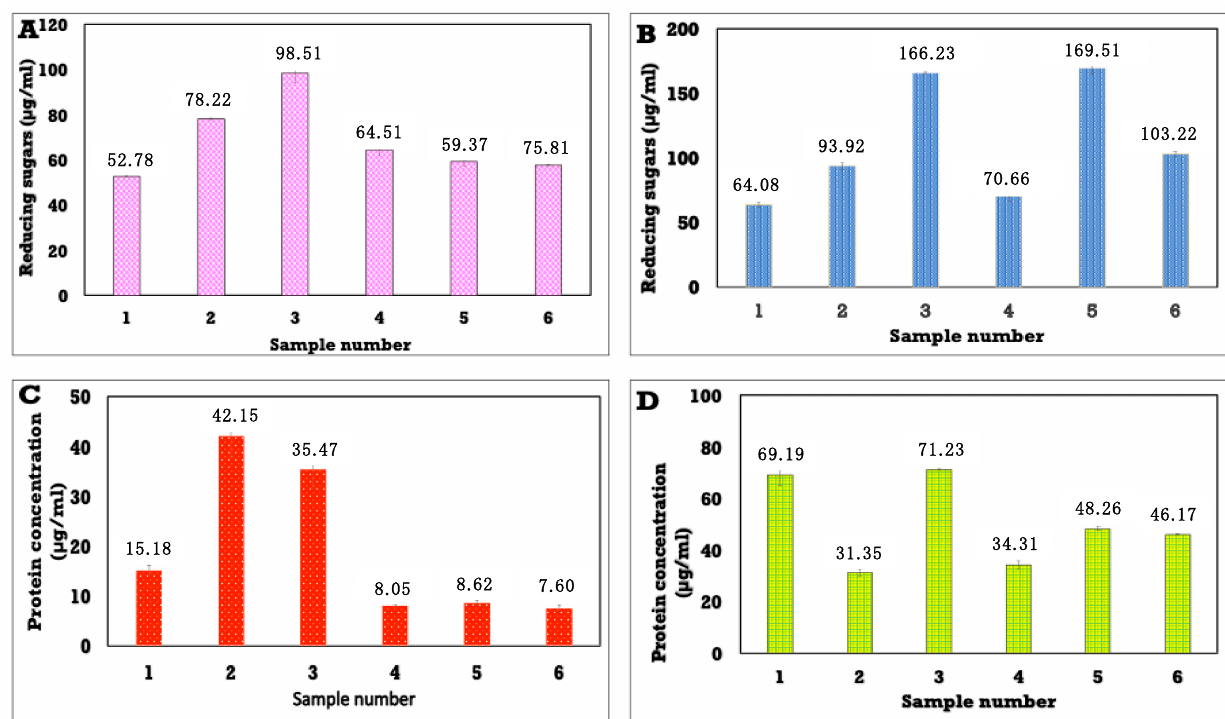
Figure 9. Reducing sugar and protein ( μ g/mL) released from S. aureus and C. albicans treated with different concentrations of anise oil-based nanoemulsions. ( A , B ): reducing sugar release from S. aureus and C. albicans , respectively, ( C , D ): protein release from S. aureus and C. albicans , respectively.